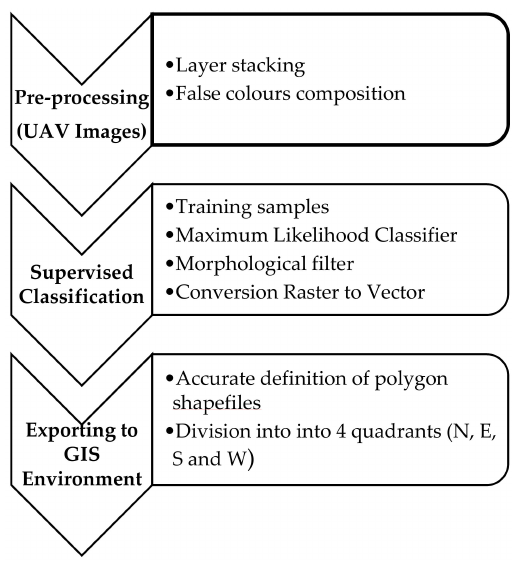
Figure 6. Main processing tasks of semi-automatic extraction of olive tree